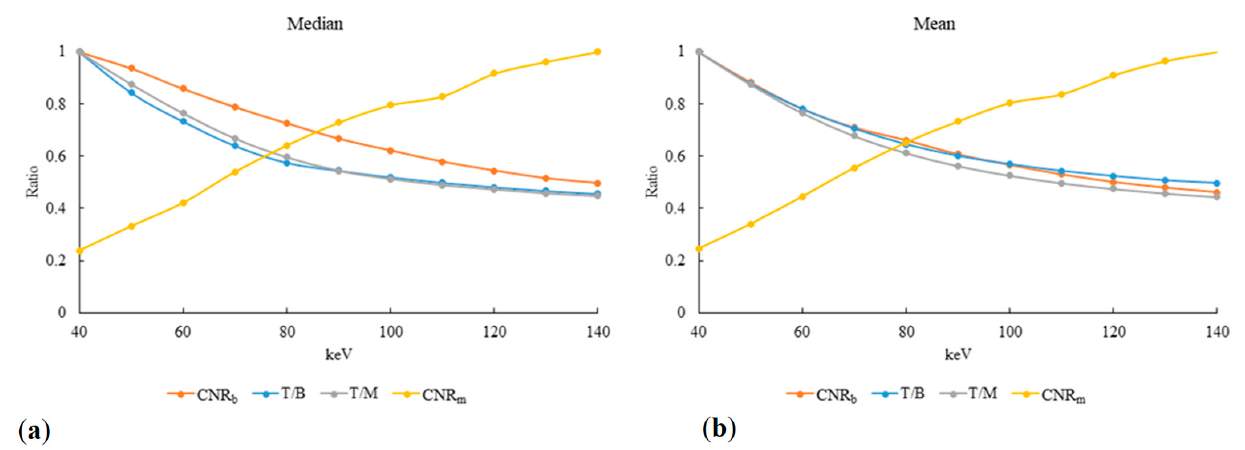
Figure 1. Standardized values of T/B (blue), T/M (gray), CNR b (orange), and CNR m (yellow) for images obtained at 40–140 keV: ( a ) median and ( b ) mean.